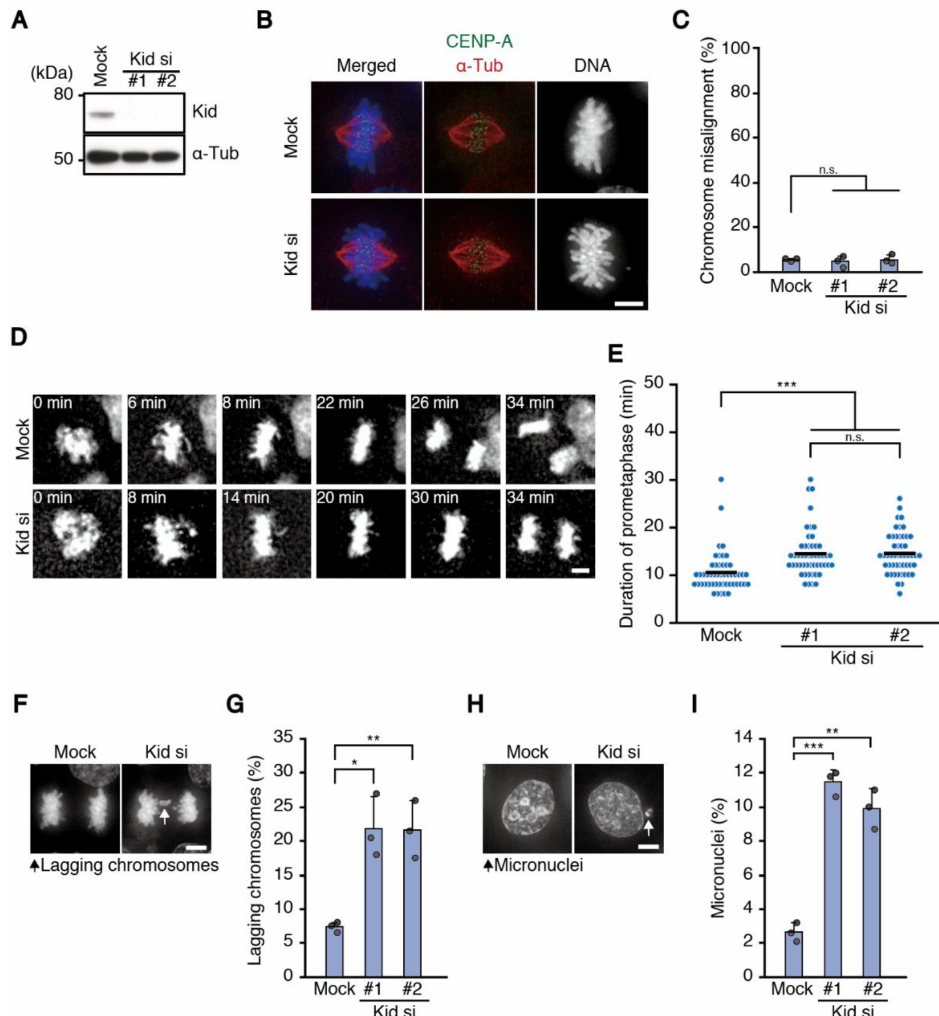
Figure 2. Cells depleted of Kid show delayed chromosome alignment and increased chromosome missegregation. ( A ) Efficiency of RNAi for Kid in HCT116 cells. Lysate of cells transfected with siRNAs against Kid was subjected to immunoblot analysis using antibodies as indicated; ( B ) chromosome alignment in cells depleted of Kid. HCT116 cells were transfected with the siRNAs for Kid shown in A , then fixed after 1 h treatment with MG132 and immunostained with an antibody against centromere protein A (CENP-A; green) and α -tubulin (red). DNA was stained with 4 (cid:48) ,6-diamidino-2-phenylindole (DAPI; blue). Only a cell depleted of Kid with one of the siRNAs (#1) is shown. Scale bar: 5 µ m; ( C ) proportion of cells with misaligned chromosomes. HCT116 cells treated as in ( B ) were observed. For each condition, 100 cells were observed. Error bars represent standard deviation (SD) of three independent experiments, and the average of each experimental result is shown as a dot. n.s., not statistically significant (Student’s t -test); ( D ) mitotic progression of mock and Kid-depleted cells. HCT116 cells expressing histone H2B-mCherry were transfected with or without the siRNAs for Kid and subjected to live cell imaging. Time from nuclear envelope breakdown is shown. Scale bar: 5 µ m; ( E ) duration of prometaphase. For cells treated as in ( D ), time from nuclear envelope breakdown to completion of chromosome alignment was measured in 50 mitotic cells for each condition. The average is indicated with a bar. n.s., not statistically significant, *** p < 0.0005 (Mann-Whitney U test); ( F ) chromosome missegregation in cells depleted of Kid. HCT116 cells were transfected with the siRNAs for Kid. After fixation, DNA was stained with DAPI, then, anaphase and telophase cells were observed. Only a cell depleted of Kid with one of the siRNAs (#1) is shown. An arrow indicates lagging chromosomes. Scale bar: 5 µ m; ( G ) proportion of cells with lagging chromosomes. For each